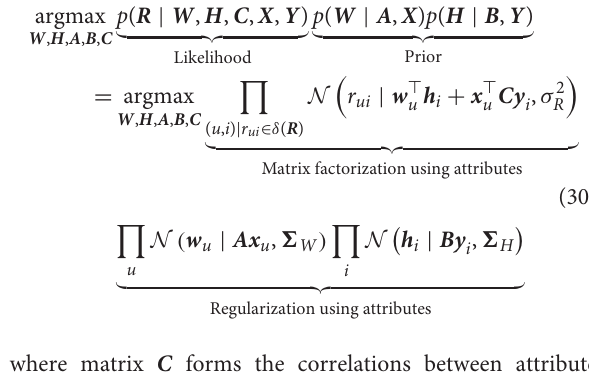
attribute information by modeling the potential correlations between X and Y :